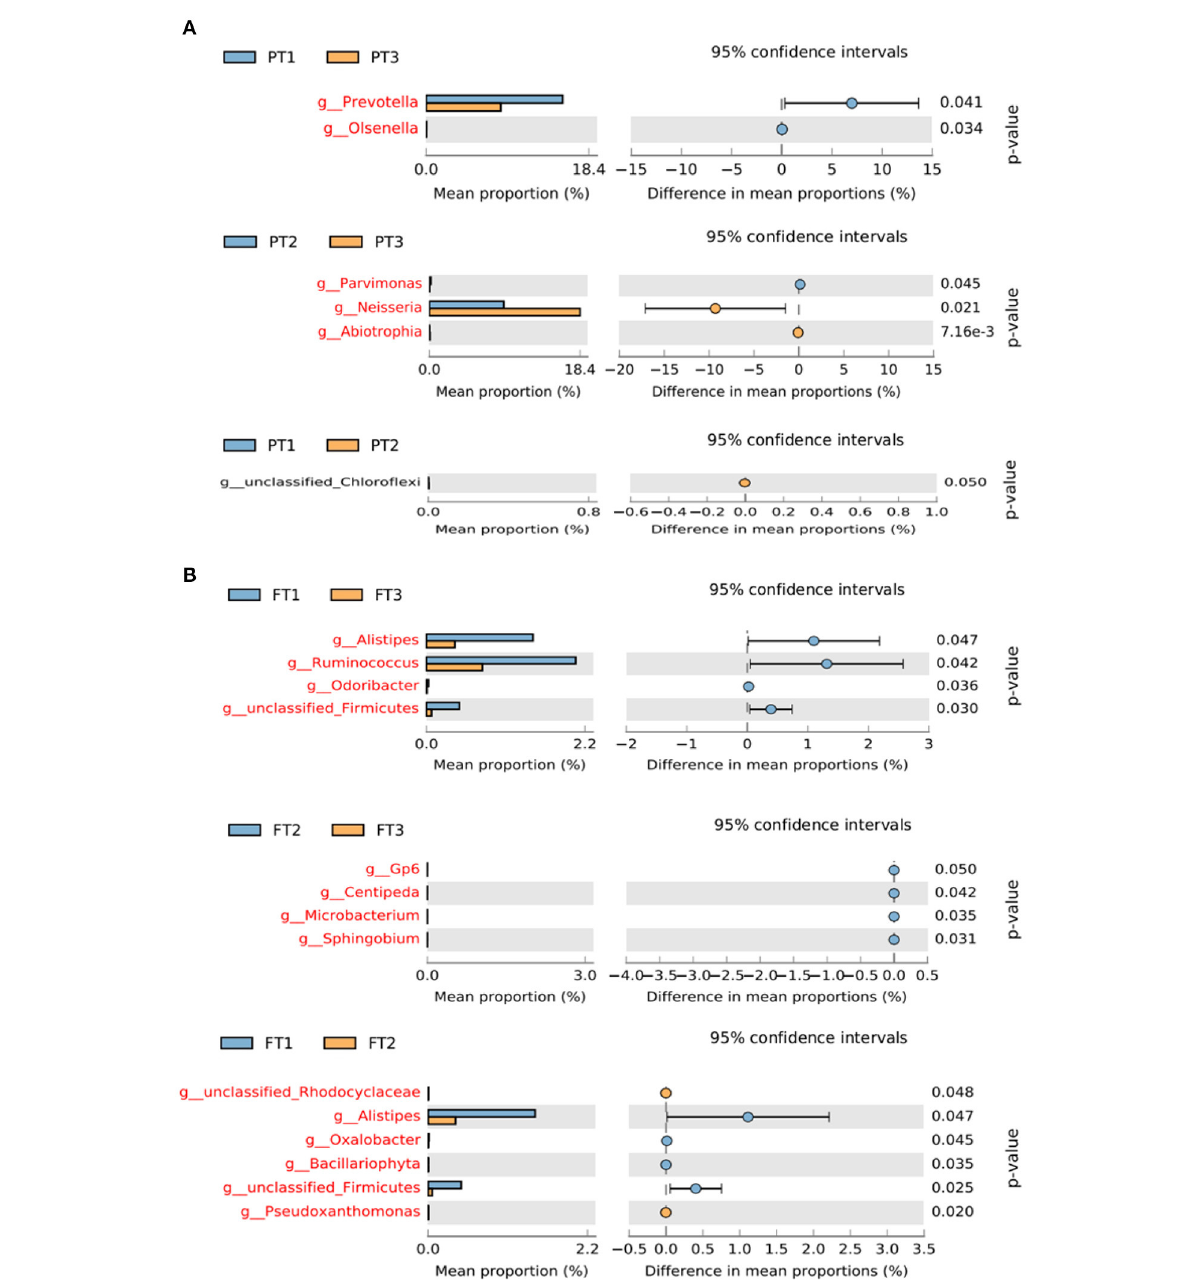
FIGURE7 Differences in the relative abundance of bacterial genera in the oral (A) and gut (B) microbiomes from the most anti-inflammatory diet group and the most pro-inflammatory diet group. The left of the figure shows the differential species between the two groups, and the right shows the difference in the mean proportions of the target species ( p <